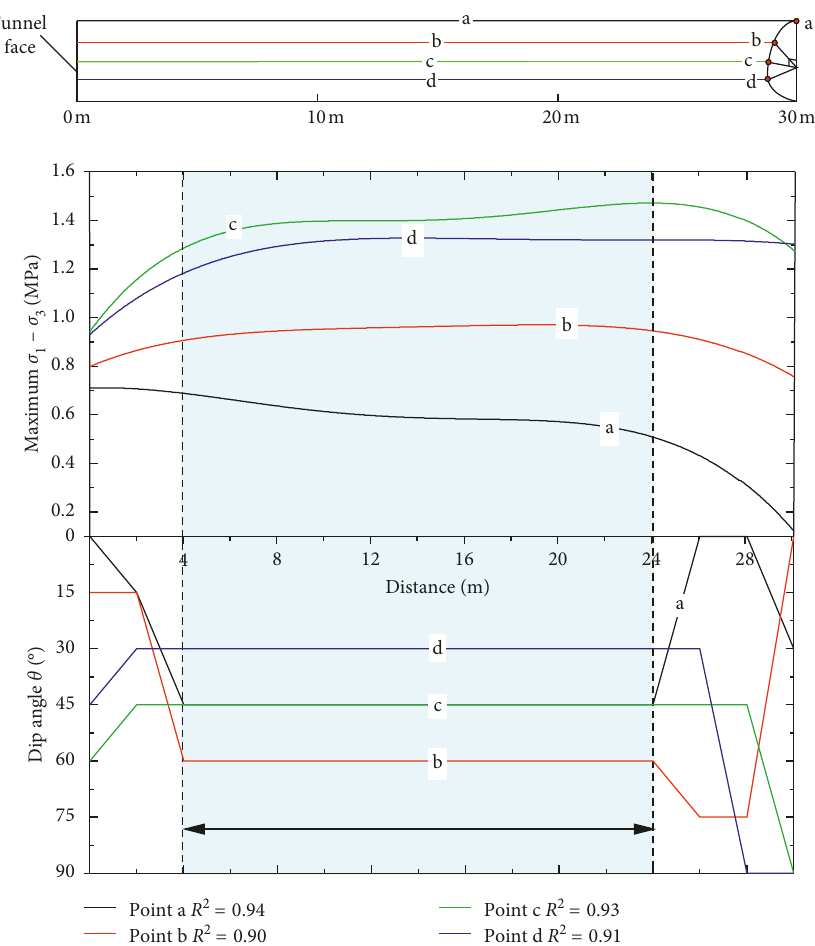
Figure 21: Maximum stress ( σ